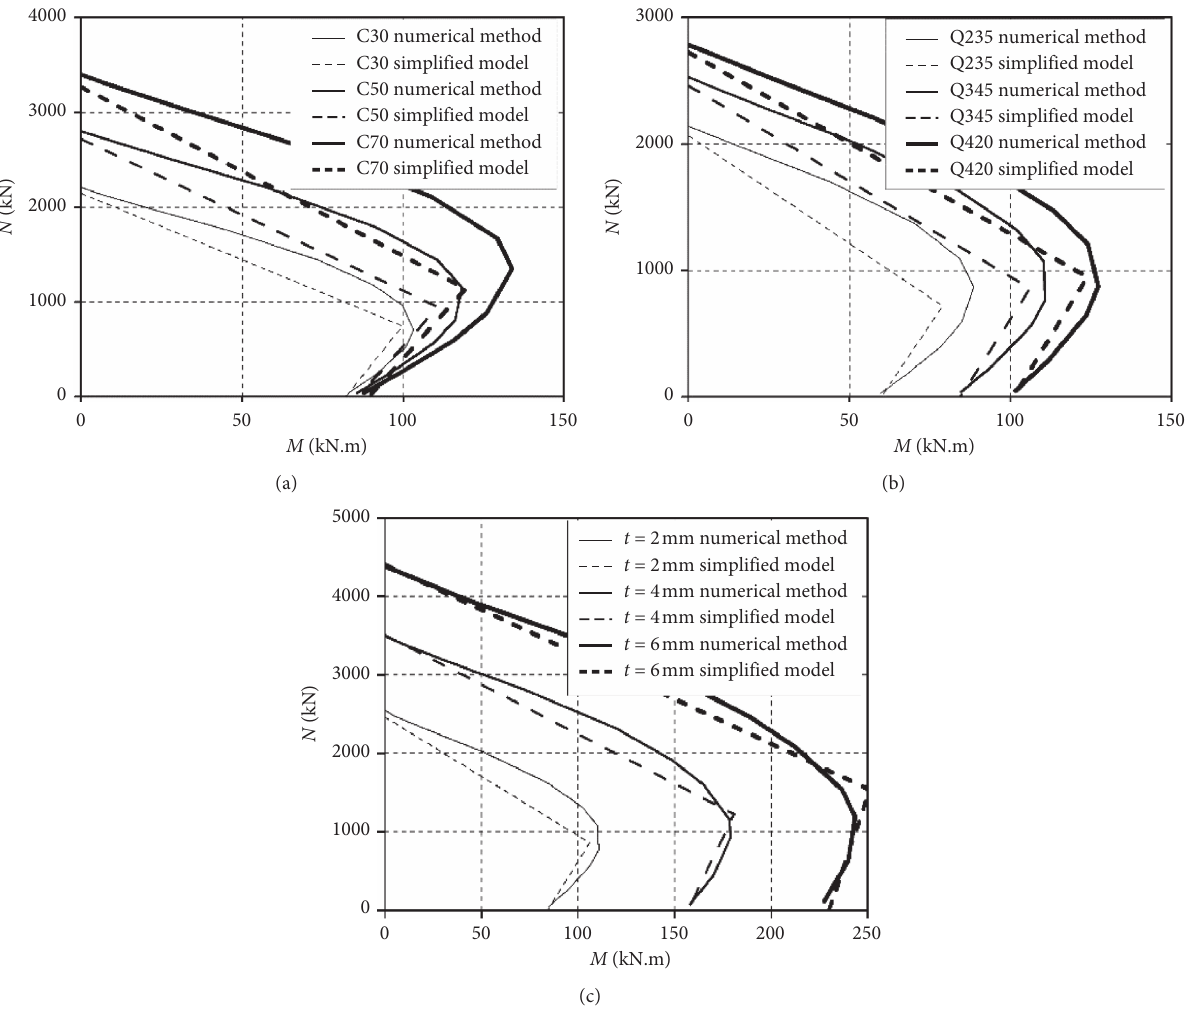
Figure 24: Verification of simplified N-M resistance model of columns. (a) Concrete strength ( f ) thickness ( t